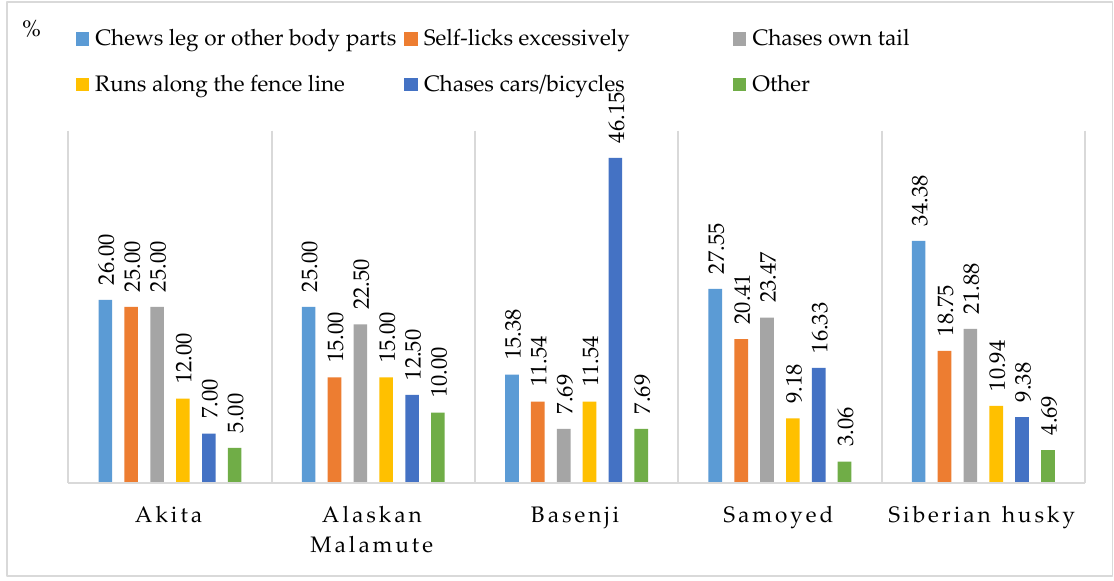
Figure 7. Oral and locomotion behaviors (%).